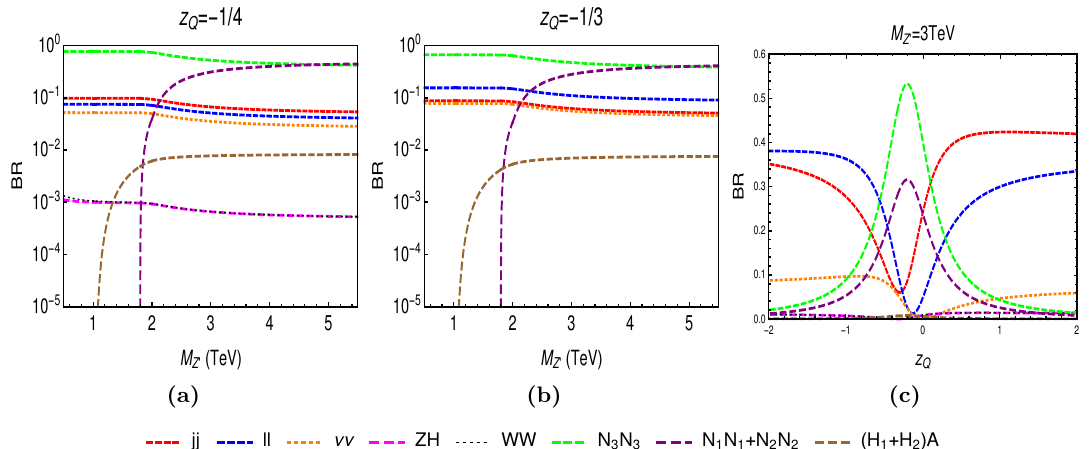
Figure 3. Branching ratios of various two-body decay modes of Z 0 as functions of its mass M Z 0 for (a) z Q = 1 = 4 and (b) z Q = 1 = 3. In (c), we show similar BRs as functions of z Q for M Z 0 = 3 (cid:0) (cid:0)